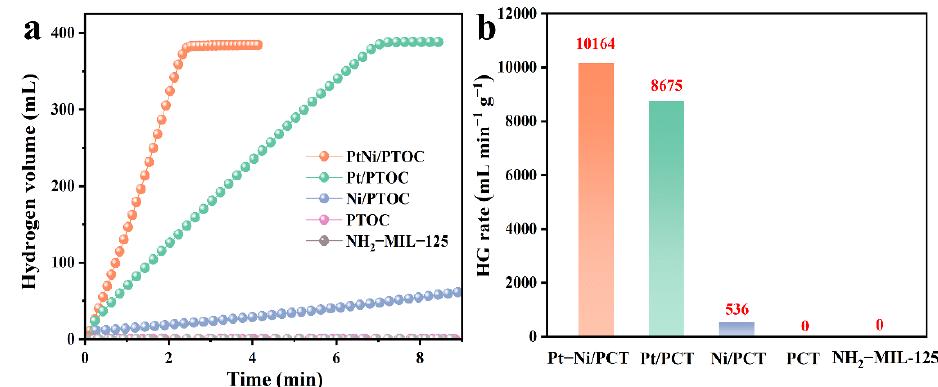
Figure 7. Hydrogen volume versus time ( a ) and HG rate bar chart of NH 2 -MIL-125, PTOC, Pt/PTOC, Ni/PTOC, and ( b ) PtNi/PTOC (reaction conditions: batch system, 25 °C, 1.5 wt% NaBH 4 + 5 wt% NaOH, 0.1 g catalyst). Table 1. Comparison of catalyst systems, reaction temperatures, HGR, Ea values, and number of cycles for NaBH 4 hydrolysis catalyzed by various catalysts.